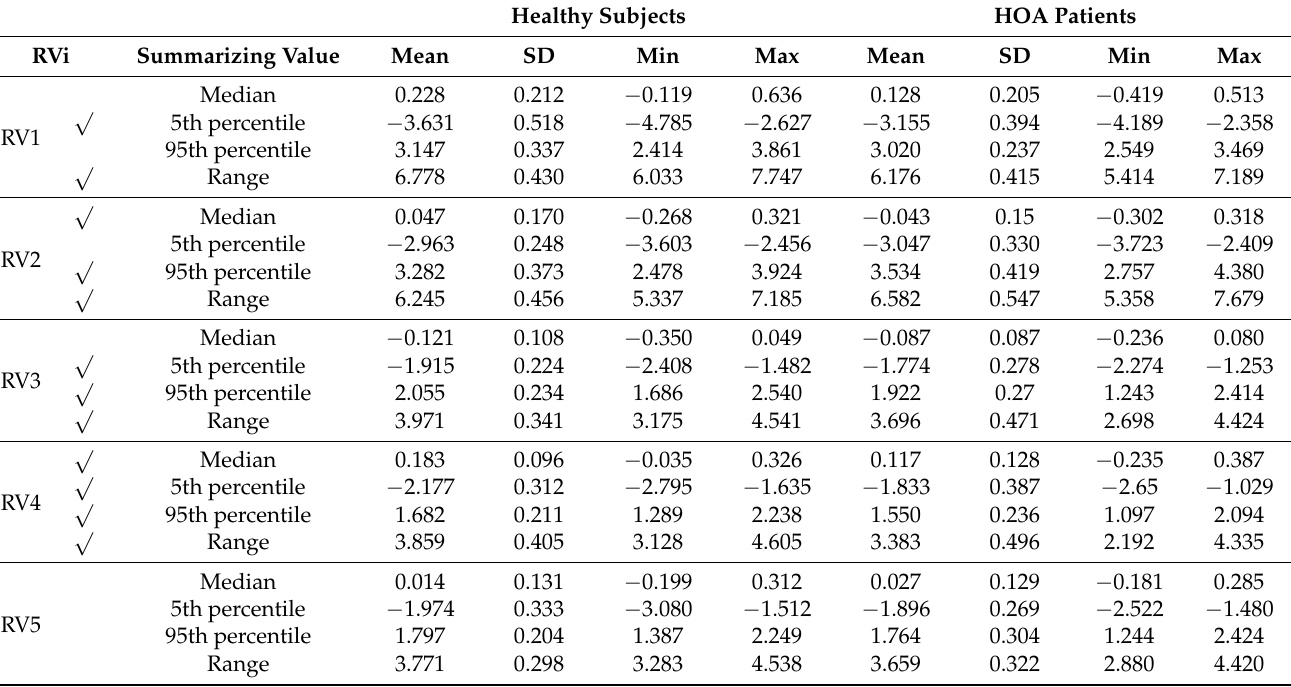
Figure 3. Variance explained (%) by each HPC and by all HPCs (Total), calculated for every subject in each sample (box and whisker plot). Table 4. Statistics of each reduced variable (RVi) summarizing value (median, 5th percentile, 95th percentile, and range as their difference) for both samples, and significant differences between healthy subjects and HOA patients samples are marked with a